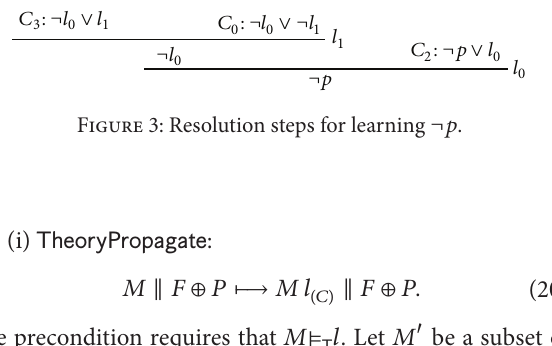
Figure 2: Example of a generalized implication graph.